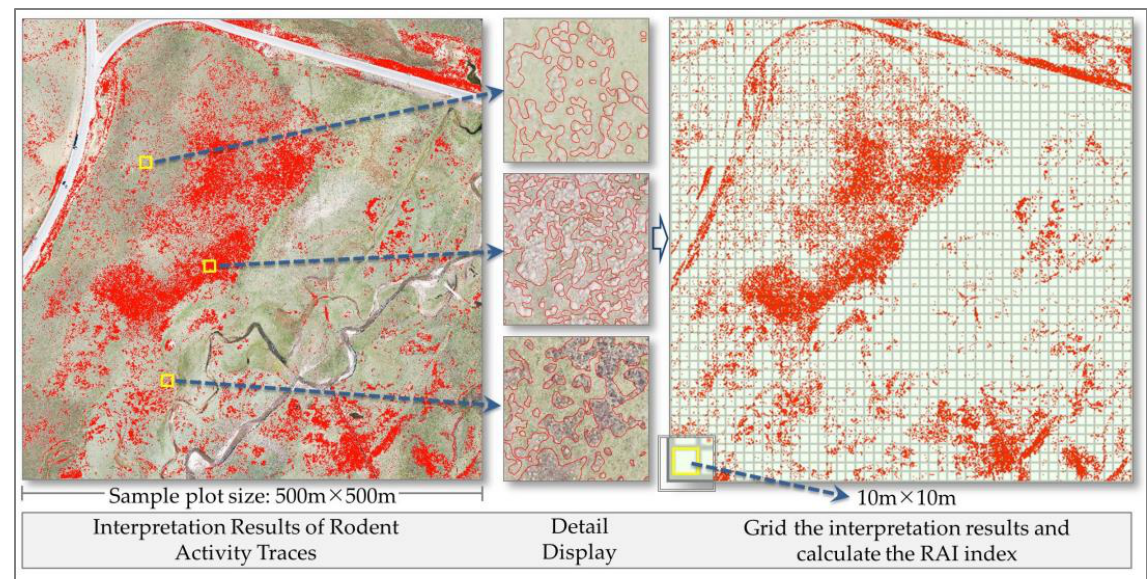
Figure 3. Interpretation results of rodent activity traces were gridded.